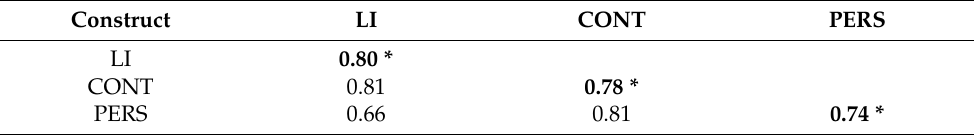
Table 5. Distinctiveness of sub-constructs of the three-factor first-order model.